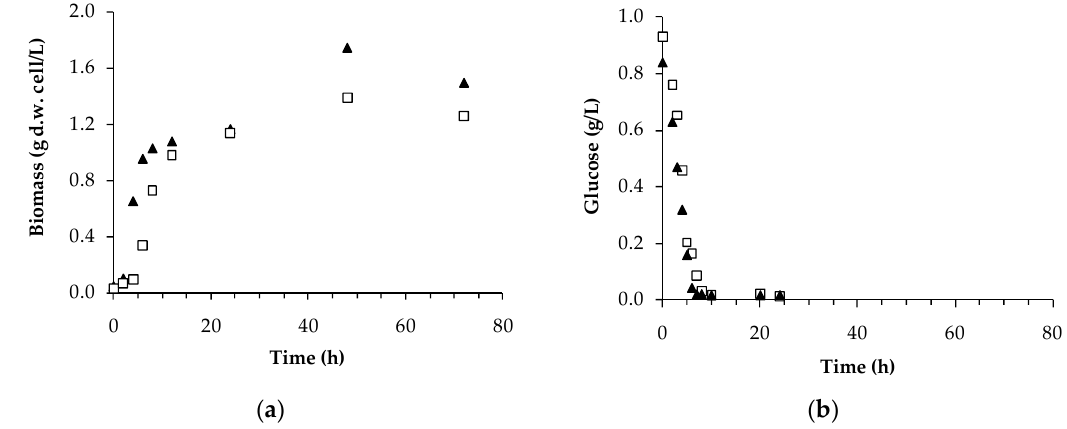
Figure 5. C. carboxidivorans growth ( a ) and glucose consumption ( b ) on Tryptone-Peptone-Yeast extract-Glucose-Arginine medium (TPYGarg) ( ▲ ) and ATCC ® 2713 ( □ ).